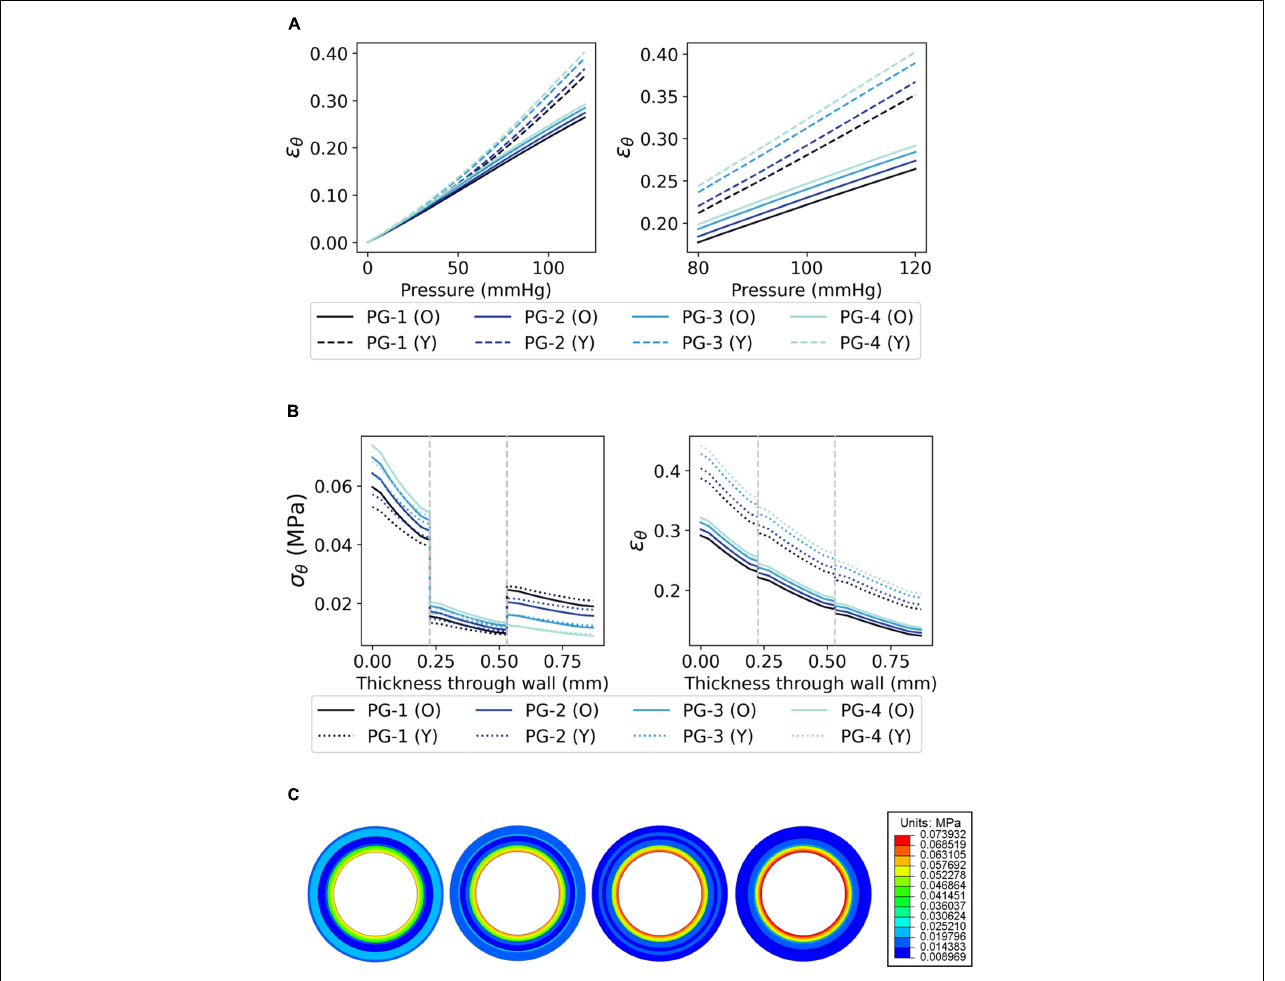
FIGURE 6 | The circumferential biomechanics of PVA/gelatin grafts at systolic pressure. (A) The mean (cid:101) θ of the PVA/gelatin graft intima between 0–120 and 80–120 mmHg pressure (error bars have been omitted for clarity). Similar trends were observed for (cid:101) θ , media , (cid:101) θ , adventitia , (cid:101) r , intima , (cid:101) r , media and (cid:101) r , adventitia ; for these, the reader is referred to Supplementary Figures 6–8 ; (B) σ θ and (cid:101) θ profiles through the radial thickness of each PVA/gelatin graft design, modelled using Ogden (solid lines) and Yeoh (dashed lines) hyperelastic parameters. Grey dashed lines represent the intima–media and media–adventitia interfaces; (C) From left to right, σ θ contour maps of each PVA/gelatin graft design using Ogden